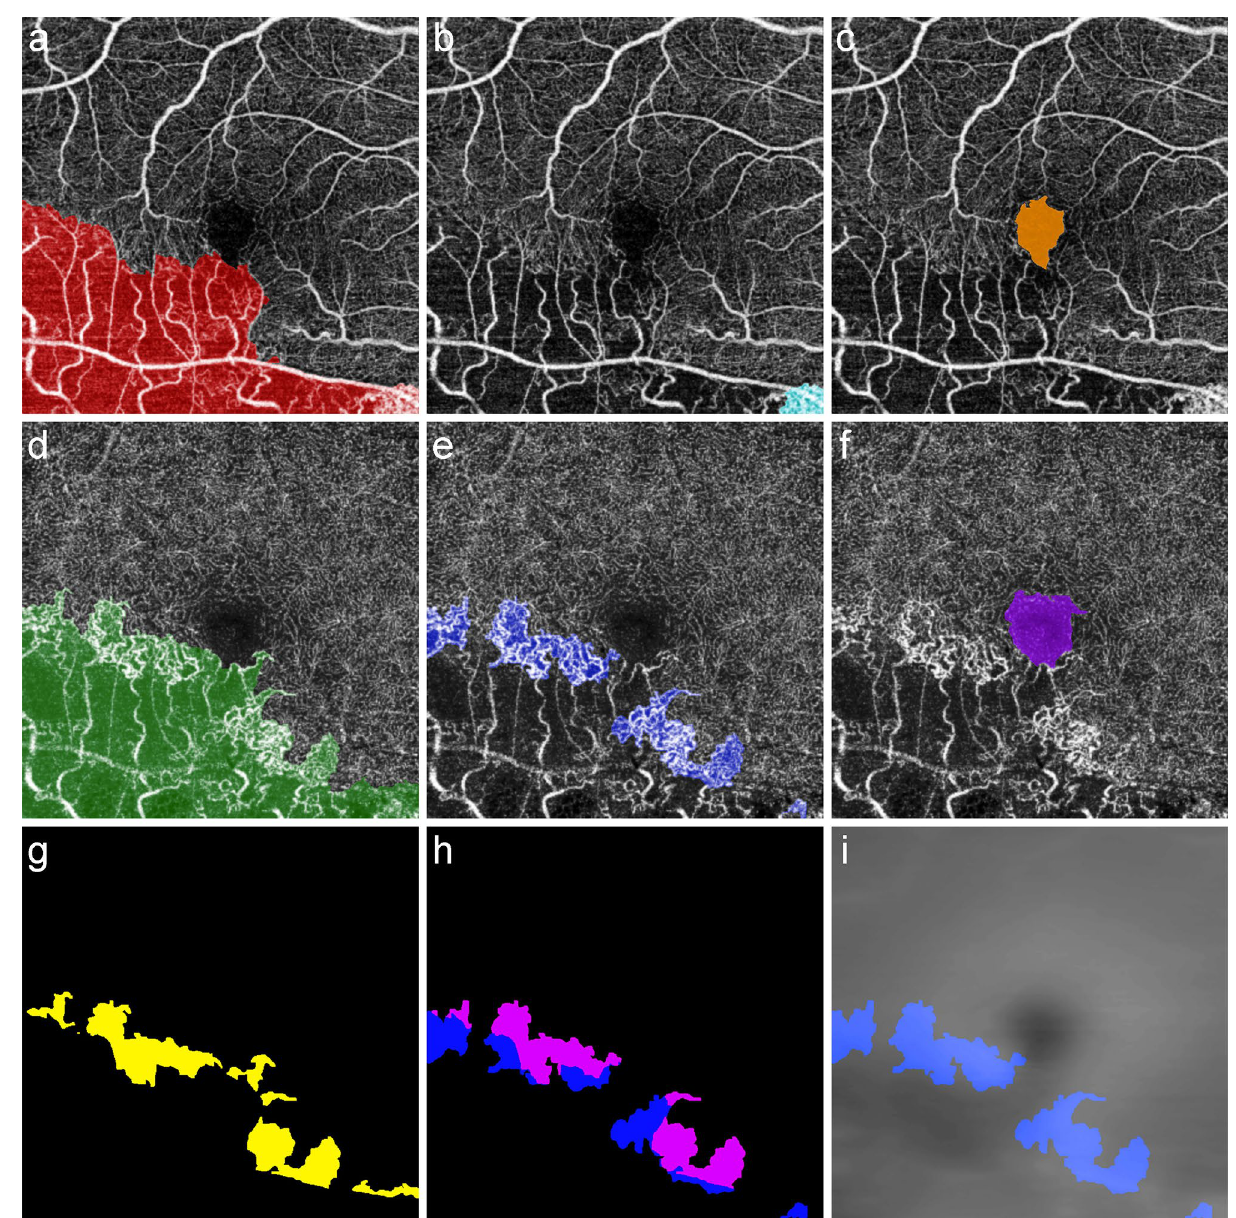
Figure 2. Segmentation of capillary congestion, abnormal vascular lesion, and foveal avascular zone in each capillary plexus. Segmentation process for the same eye shown in Fig. 1. ( a ) Red indicates an abnormal vascular lesion of the superficial capillary plexus (SCP-A). ( b ) Cyan indicates capillary congestion of the SCP. ( c ) Orange indicates the foveal avascular zone (FAZ) of the SCP. ( d ) Green indicates an abnormal vascular lesion of the deep capillary plexus (DCP-A). ( e ) Blue indicates capillary congestion of the DCP (DCP-C). ( f ) The purple region is the FAZ of the DCP. Ophthalmologists saved these six sets of manual segmentation data as 600 × 600 size of two-dimensional binary matrices composed of TRUE or FALSE. Colored pixels were assigned to TRUE and colorless pixels to FALSE. ( g ) DCP-A was larger than SCP-A, and the transitional zone (TZ, yellow) was formed in the region of abnormal DCP under normal SCP. ( h ) The DCP-C image was superimposed on the TZ. The pink-colored region indicates DCP-C comprised in the TZ, and 45.0% of DCP-C was spread in the TZ. ( i ) The gray-scaled retinal thickness map was superimposed on the segmented DCP-C image. The mean retinal thickness of the DCP-C (blue region) was calculated to be 276.1 µm at